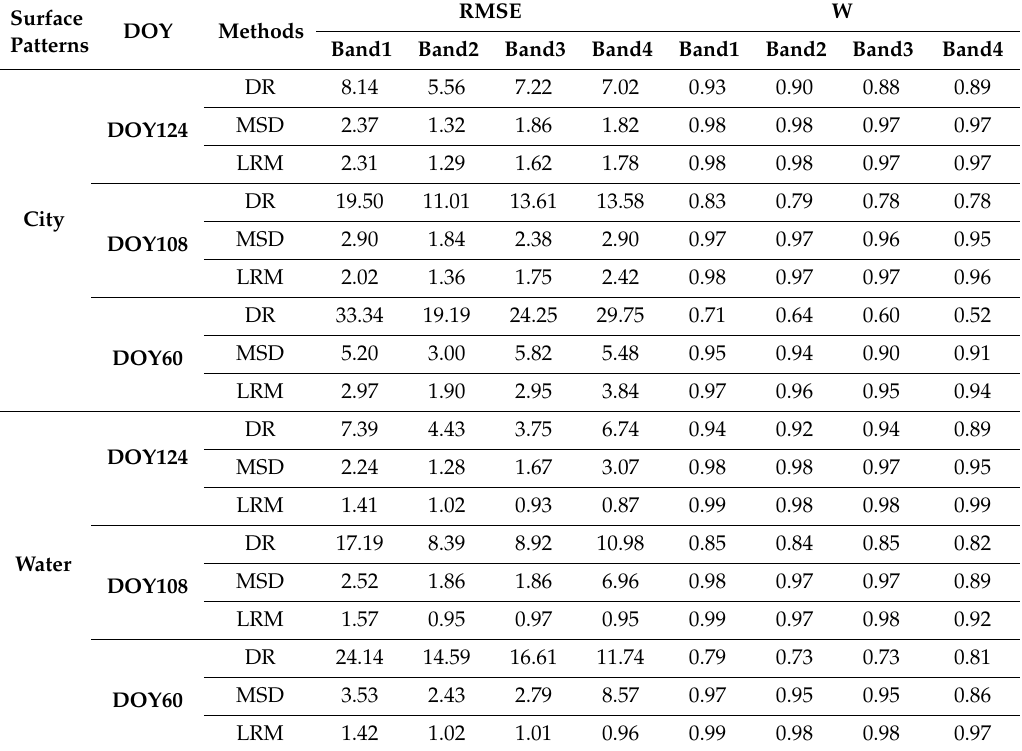
Table 2. Accuracy of cloud removal over a small patch (20 × 20 pixels) assumed to be cloudy using three di ff erent reference images in the TM image of